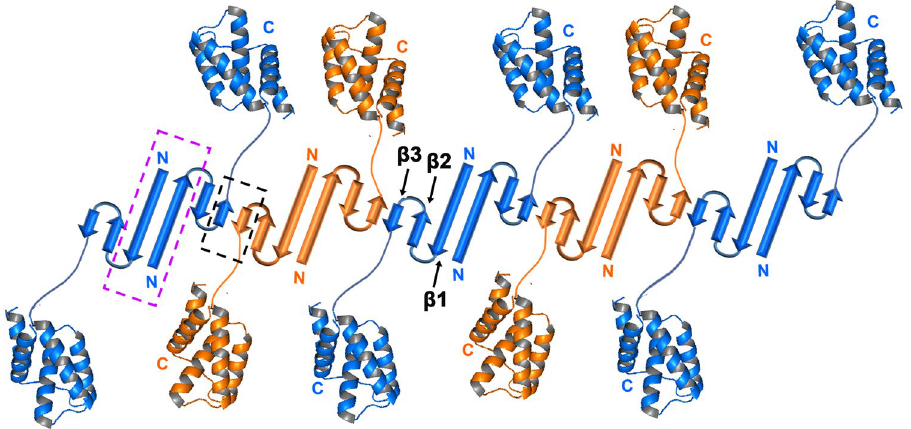
Figure 8. Schematic representation showing one of the probable mechanisms for amyloidogenesis in CarD. We assume that the N-terminal domains of CarD probably self-associate by β -sheet augmentation (shown in black box with broken line) leading to the formation of amyloid-like fibrils. The flexible linker may allow C-terminal domain to adopt conformation suitable for the formation of amyloids. The repeating homodimers of CarD are shown in blue and orange colors and the region responsible for domain-swapping is shown in magenta box with broken lines. For clarity, N-terminal domain has been shown as a topological diagram and C-terminal domain has been shown in cartoon